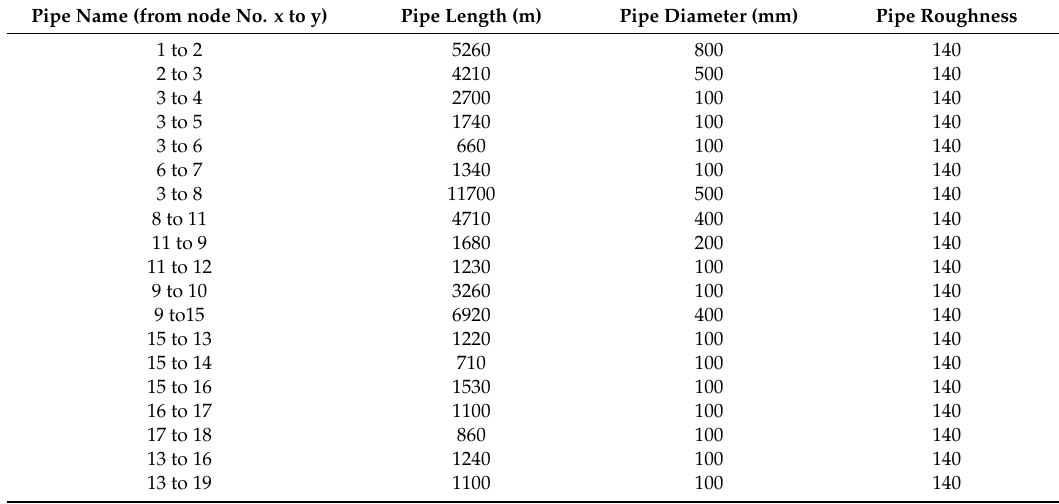
Table 4. Pipe length, diameter and roughness of water distribution lines from Ggaba II to Mukono. The name of the numbered sites or nodes is as shown in Table